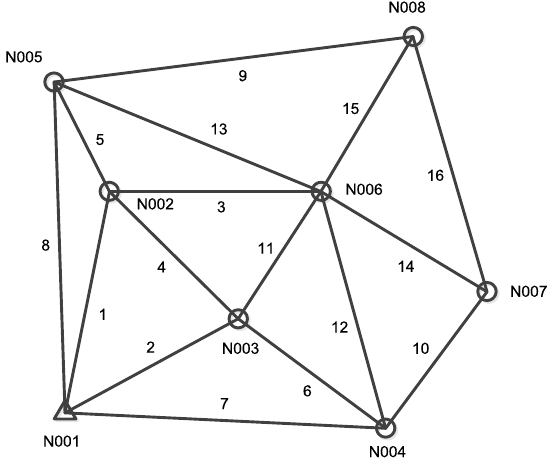
Figure 1. Shape of the GNSS network.